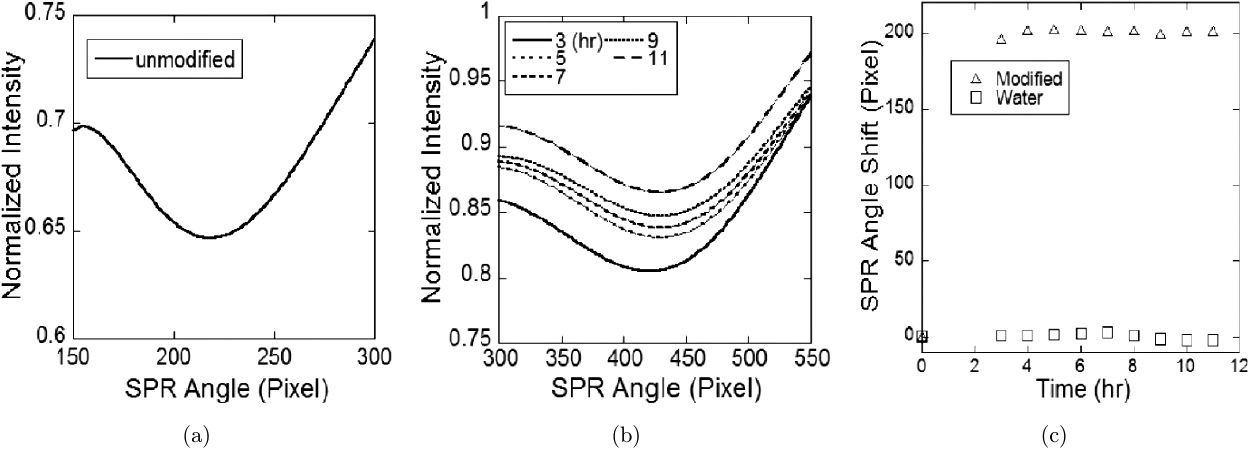
Fig. 3. The in°uence of modi¯cation. (a) SPR curves and resonance angles of water before the modi¯cation. (b) SPR curves and resonance angles of water in di®erent modi¯cation time. (c) SPR angle shift comparison of two prisms according to time.